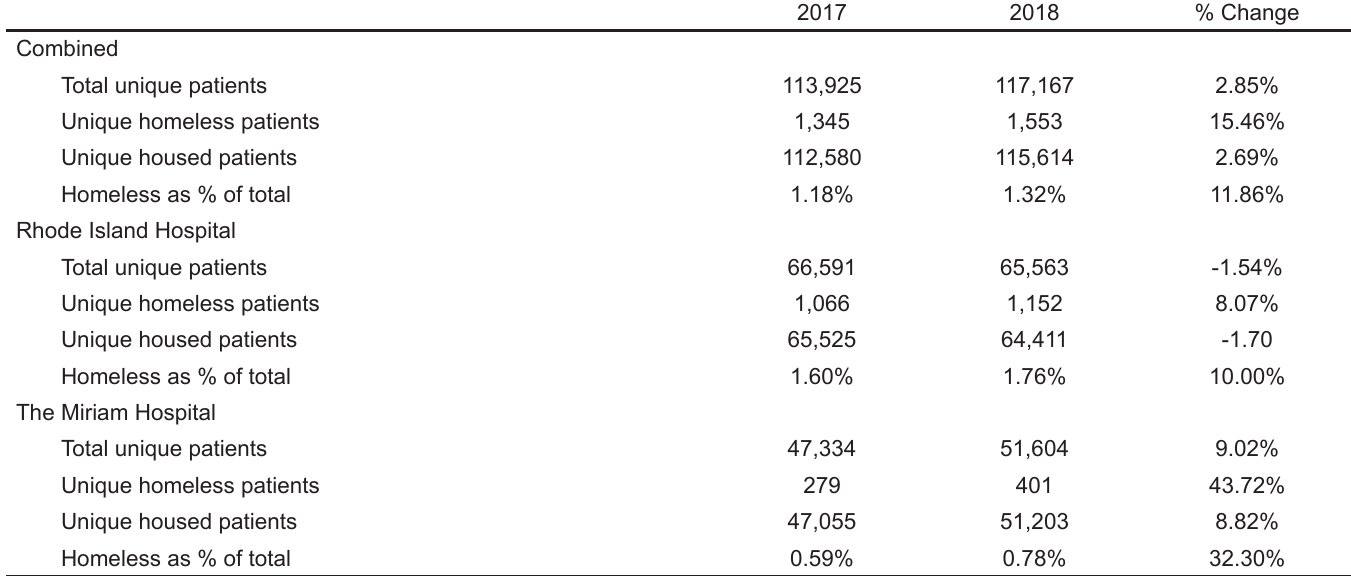
Table 3. Total unique patients seen in Rhode Island Hospital and The Miriam Hospital emergency departments in 2017 and 2018, showing percent change after closure of Memorial